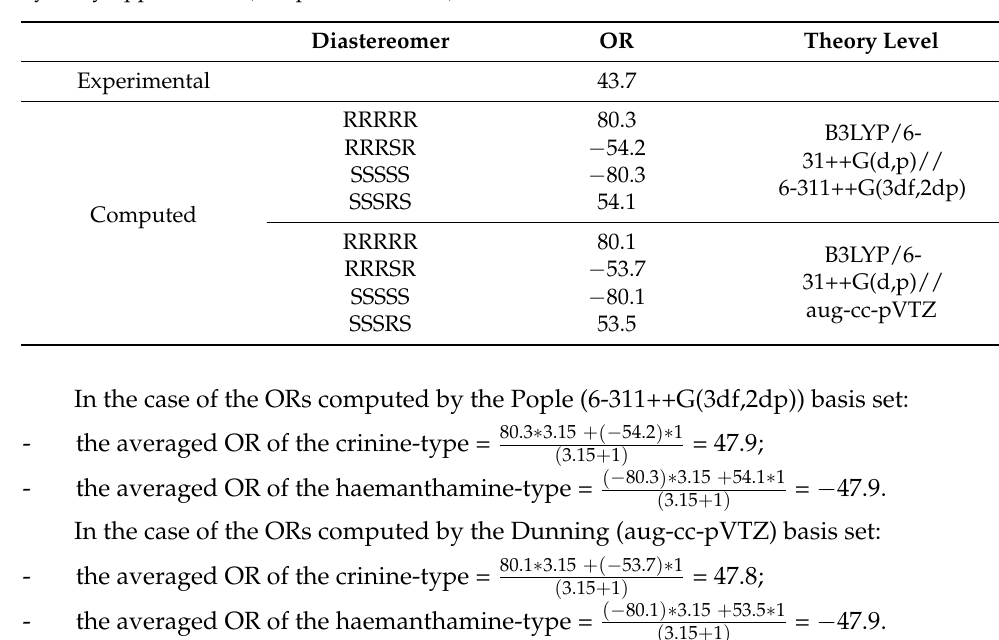
Experimental and computed optical rotation values for two 6-epimers of 6- hydroxyhippeastidine (compounds 1 and 2